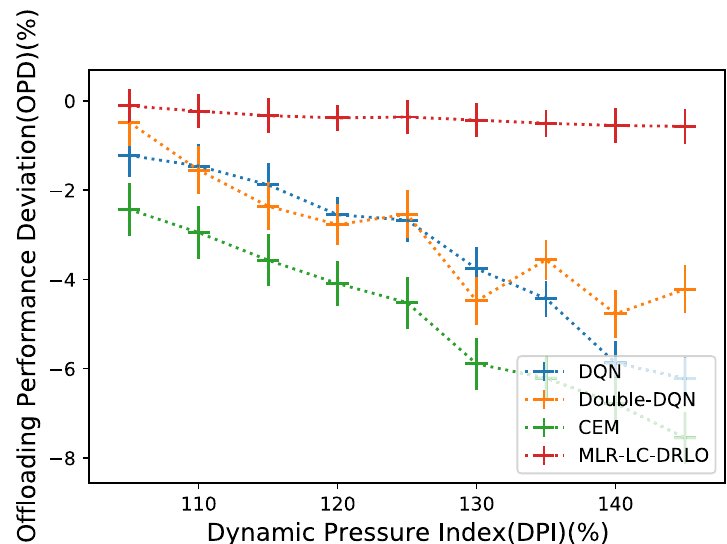
Fig. 5 Performance deviation of MLR-LC-DRLO and other 3 fine-tuned other fine-tuned RL-based approaches: with the same amount of DPI, MLR-LC-DRLO experiences lower performance deviation